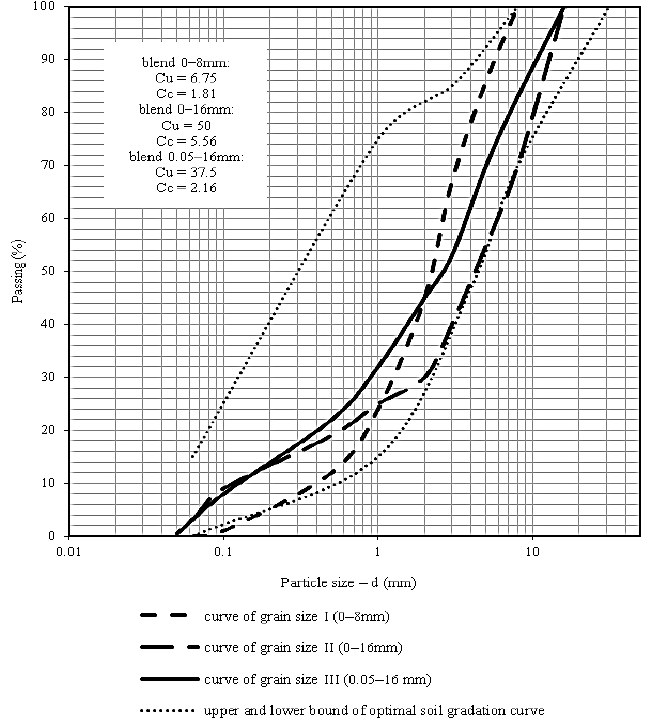
Figure 1. Grain size distribution curve of each blend.